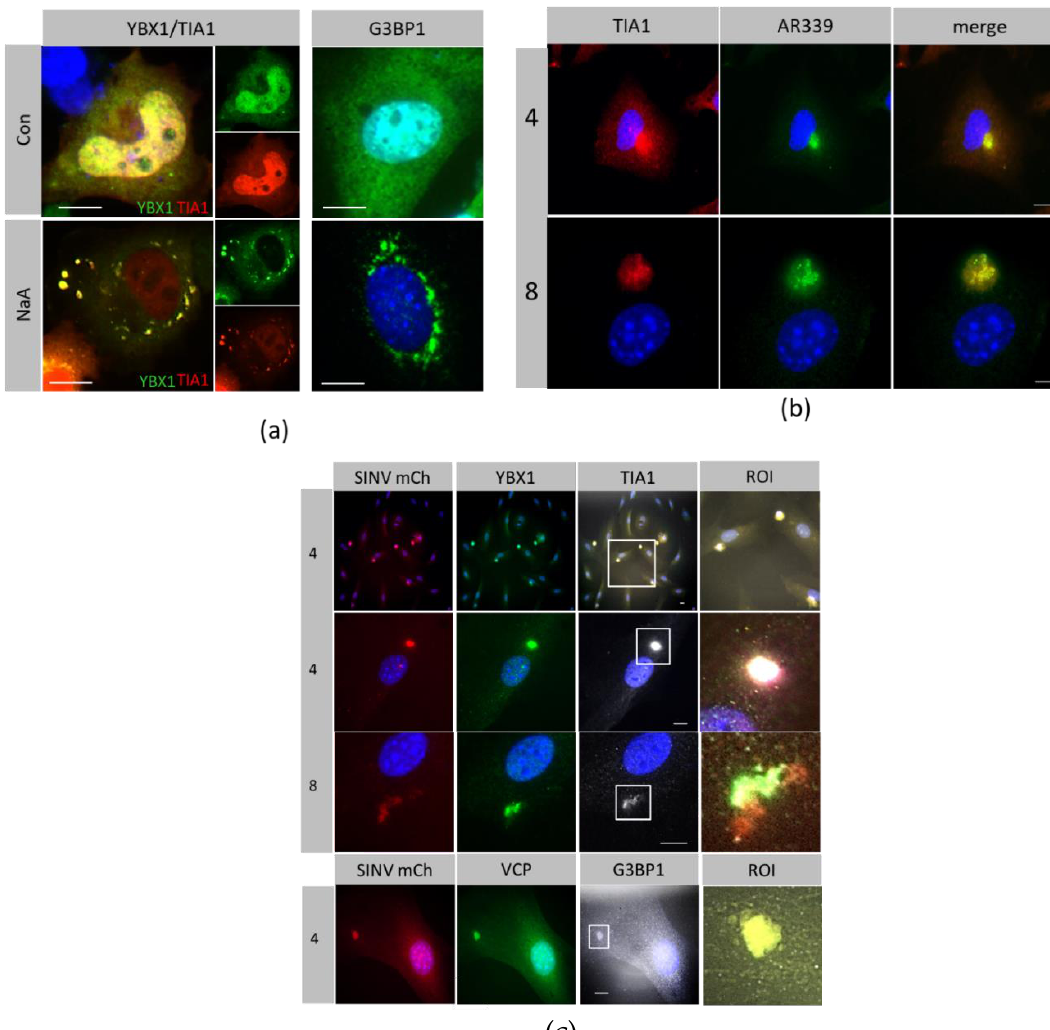
Figure 2. RNA binding proteins redistributed with SINV capsid early in infection. Host RNA-binding proteins YBX1, TIA 1, G3BP1 and VCP were detected by immunostaining ( a ) Control MEF cells (Con) and cells treated with 100 nM sodium arsenate for 2 h (NaA) ( b ) MEFs infected with SINV strain AR339 for 4 and 8 hpi ( c ) Cells infected with SINV Cherry.capsid for 4hpi (low power x40), 4 hpi (x63) and 8 hpi (x63). Region of interest (ROI) are from merged images of white squares. Scale bar = 10 µ RNA-binding proteins VCP, YBX1 and TIA1 were initially found in the nucleus and cytoplasm